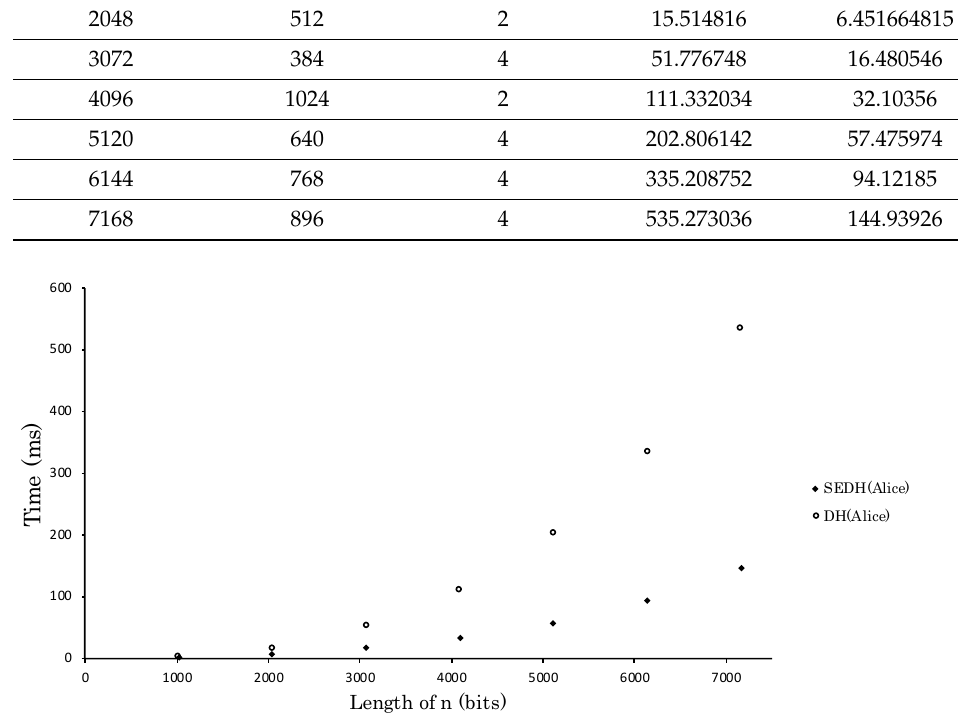
Figure 5. Comparison of calculation times (ms) for Alice with